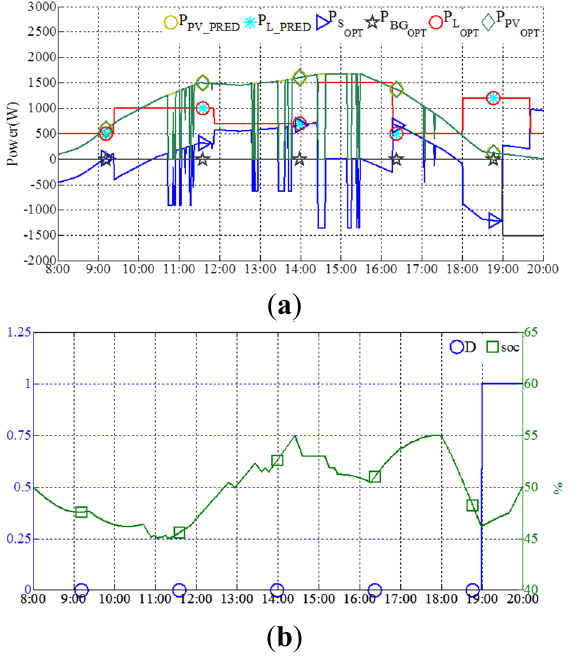
Figure 11. ( a ) Predicted and optimized power flow for Test 2; ( b ) D and soc evolution given by optimization for Test